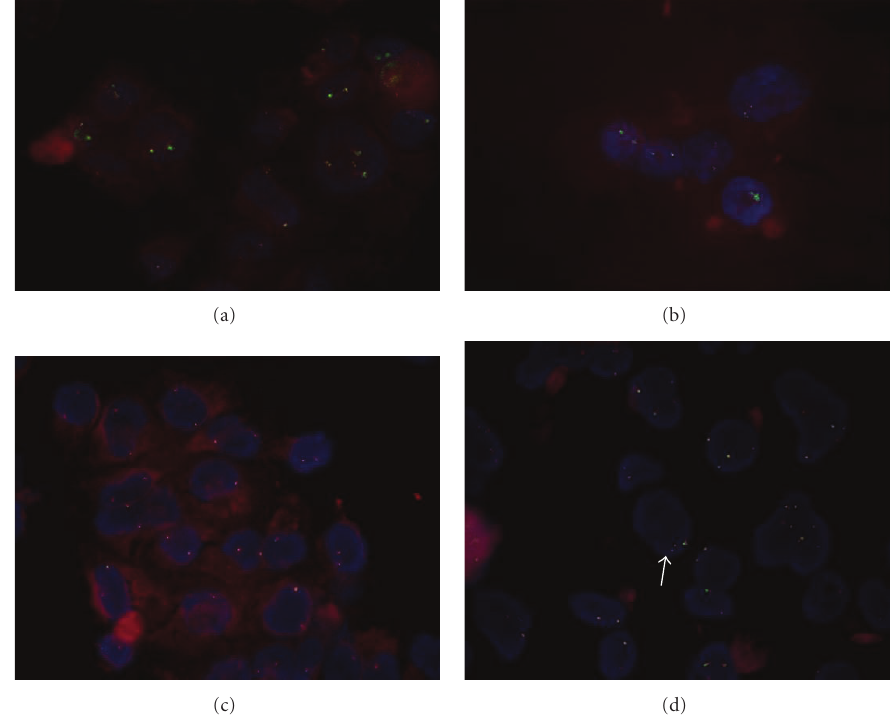
Figure 4: FISH analysis for BCL2 (a, b) and MYC (c, d) for untreated (a, c) and E. tirucalli -treated cells (b, d). No balanced translocations have been detected, though multiple signals for MYC have been identified. Arrows indicate cells with multiple MYC signals.